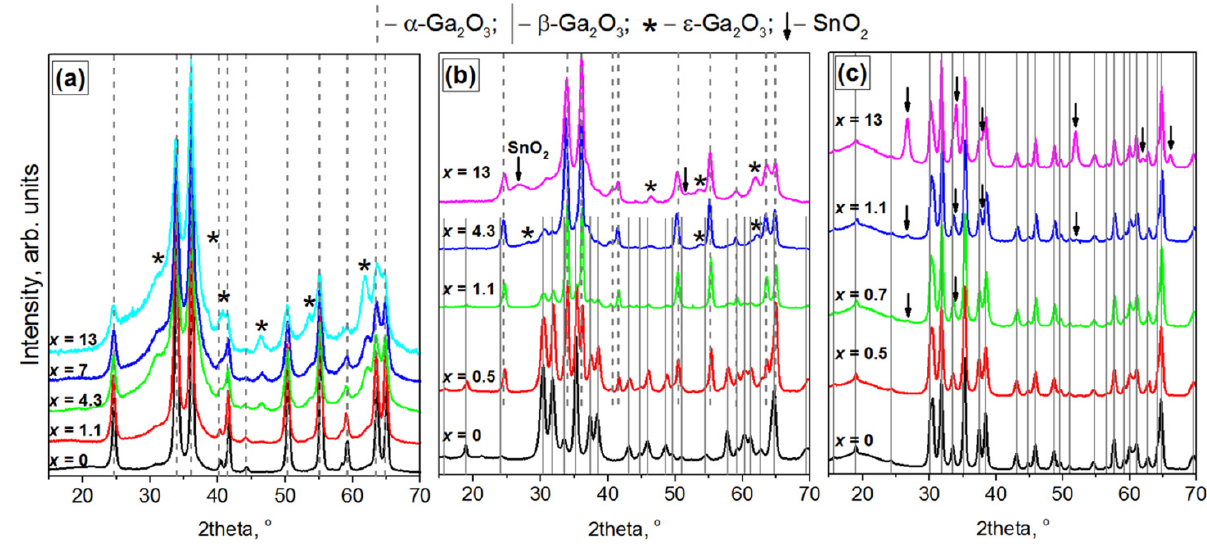
Figure 2. XRD patterns of Ga 2 O 3 (Sn), annealed at ( a ) 500, ( b ) 750 and ( c ) 1000 °C. Dash lines correspond to α -Ga 2 O 3 phase; solid lines–to β -Ga 2 O 3 phase; (*)—to ε -Ga 2 O 3 phase; ( ↓)—to SnO 2 phase.